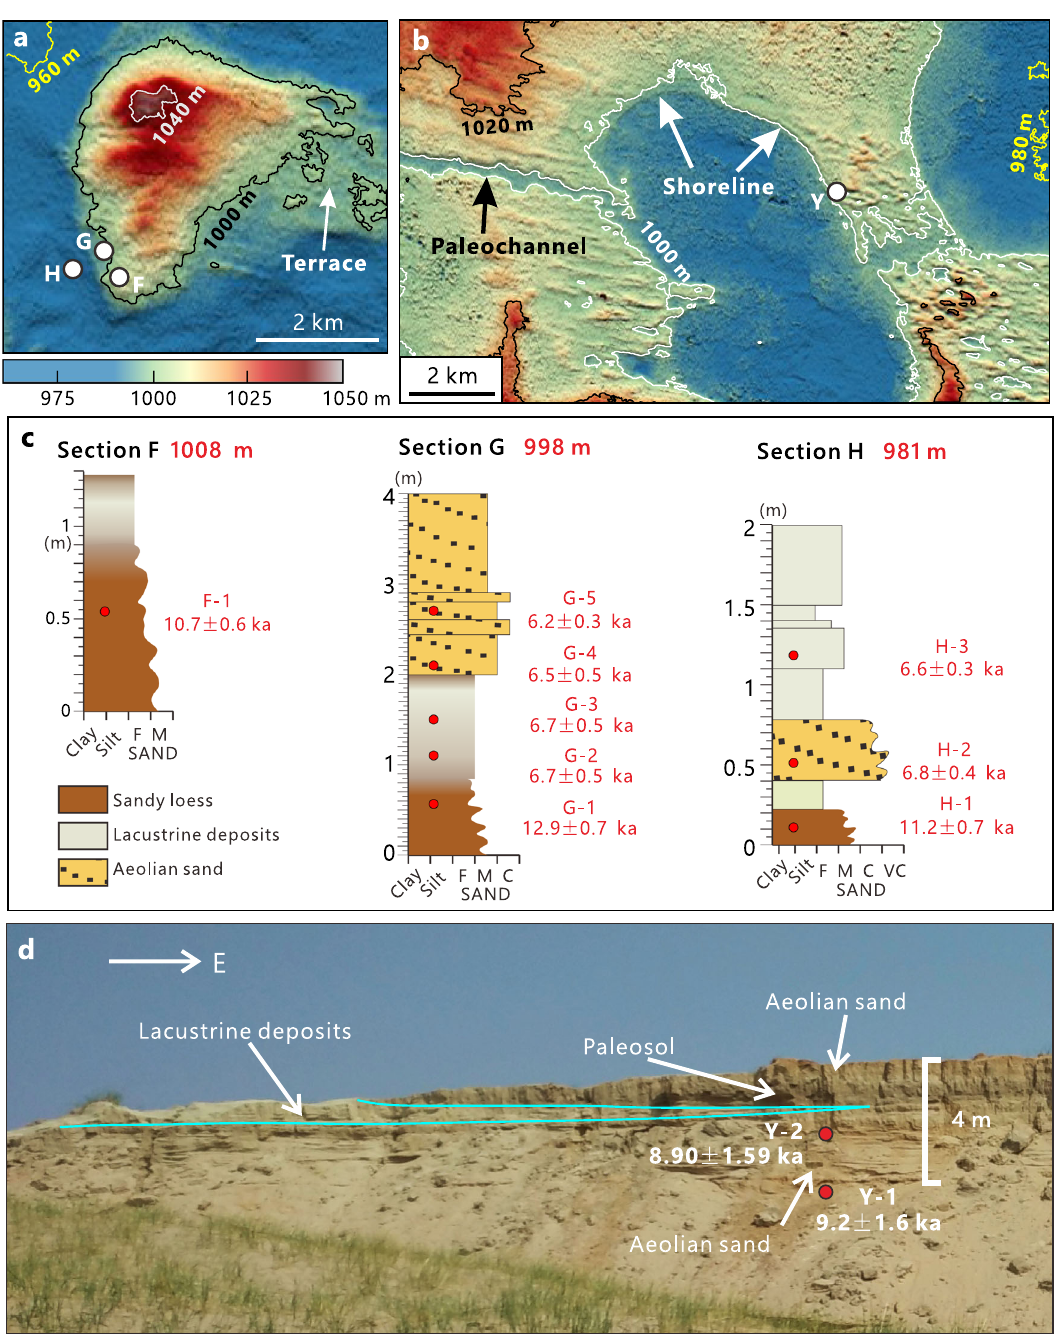
the two panels).SectionsF,G and H aresituated on the southwest side ofa former island. Lacustrine deposits have been found in all three sections and are located at different elevations. Beach ridges are visible at ~1000m in panel ( b ). c